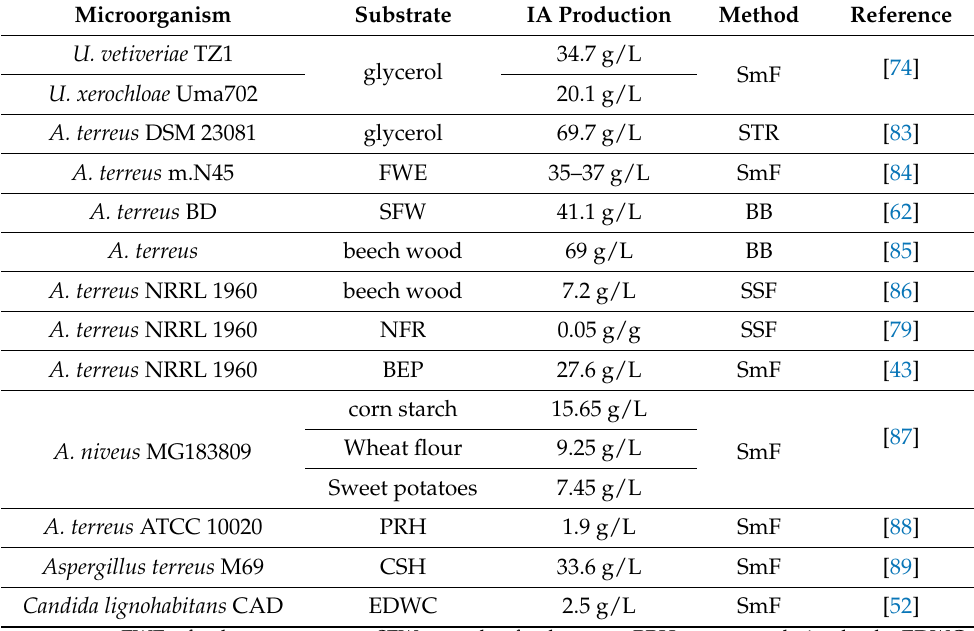
Table 2. Alternative substrate-based IA